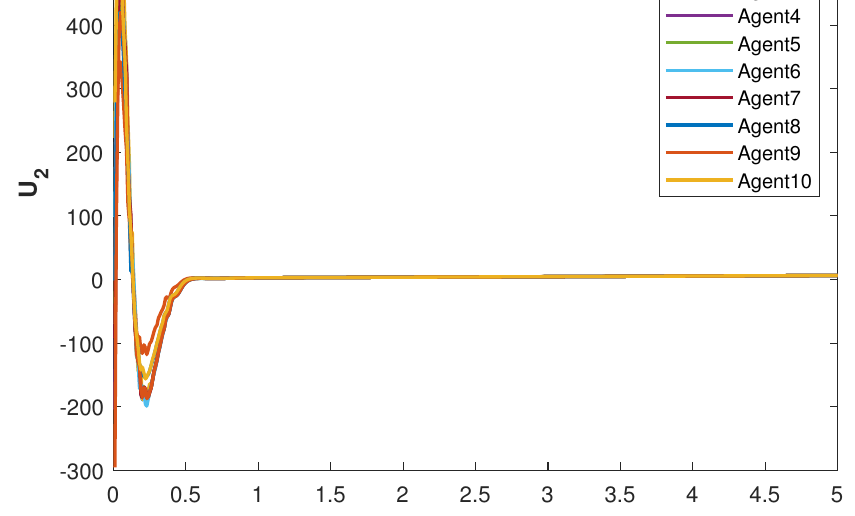
Figure 2. Control U 2 of agents.